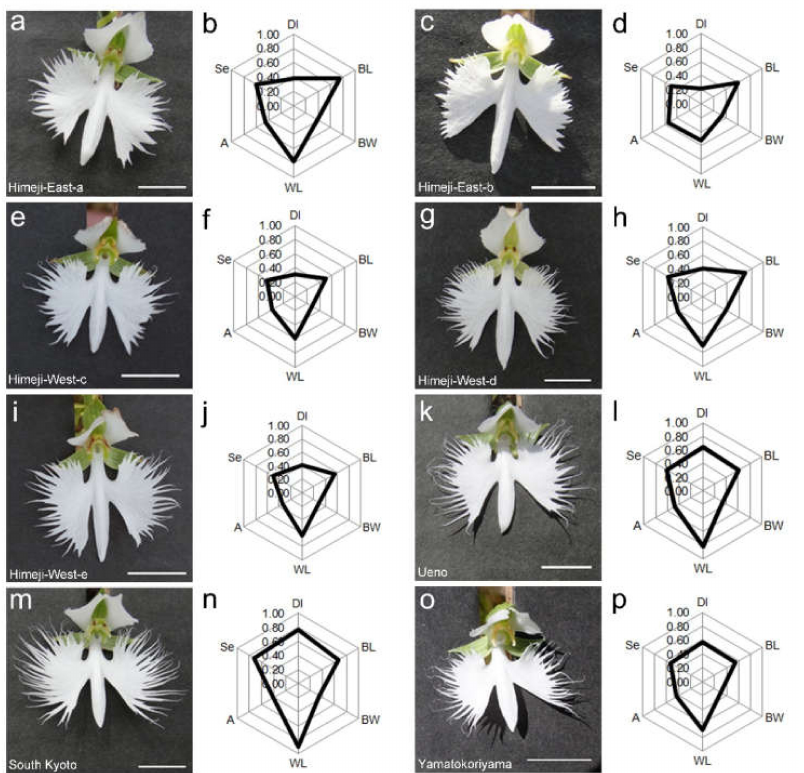
Figure 2. Flowers and quantification of lip shapes of H. radiata from eight habitats in the Kinki area. ( a , c , e , g , i , k , m , o ) Flowers of each population. Scale bars: 1 cm. ( b , d , f , h , j , l , n , p ) Quantification of lip shape shown by six parameters. DI, dissection index; BL, body length; BW; body width; WL, wing length; A, angle; Se, serration number. ( a , b ) Himeji East–a ( n = 6). ( c , d ) Himeji East–b ( n = 8). ( e , f ) Himeji West–c ( n = 3). ( g , h ) Himeji West–d ( n = 17). ( i , j ) Himeji West–e ( n = 6). ( k , l ) Ueno ( n = 5). ( m , n ) South Kyoto ( n = 14). ( o , p ) Yamatokoriyama ( n =